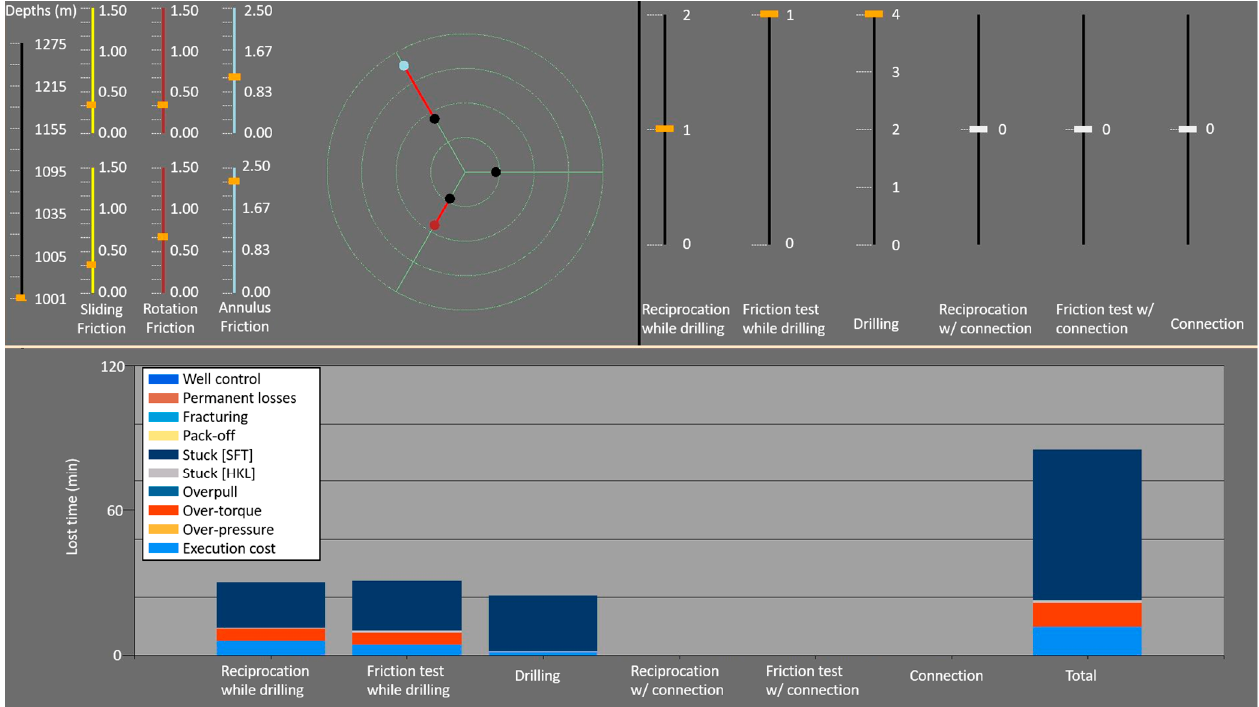
Figure 9. Risks associated to an action applied to a state. Given a state (top-left quadrant) and an action (in this case performing one reciprocation, one friction test and then drilling with minimum speed) one computes a cost. The components of this cost are shown in the bottom chart: to each of the successive actions is associated both an execution cost (blue part) and some risk cost. One sees that while reciprocating and performing the friction test, the risks of having an over-torque safety trigger (red) are non-neglectable, as well as the risk of being rotationally stuck (dark blue). Only this risk subsists during drilling, since the top-drive safety trigger is not active then.